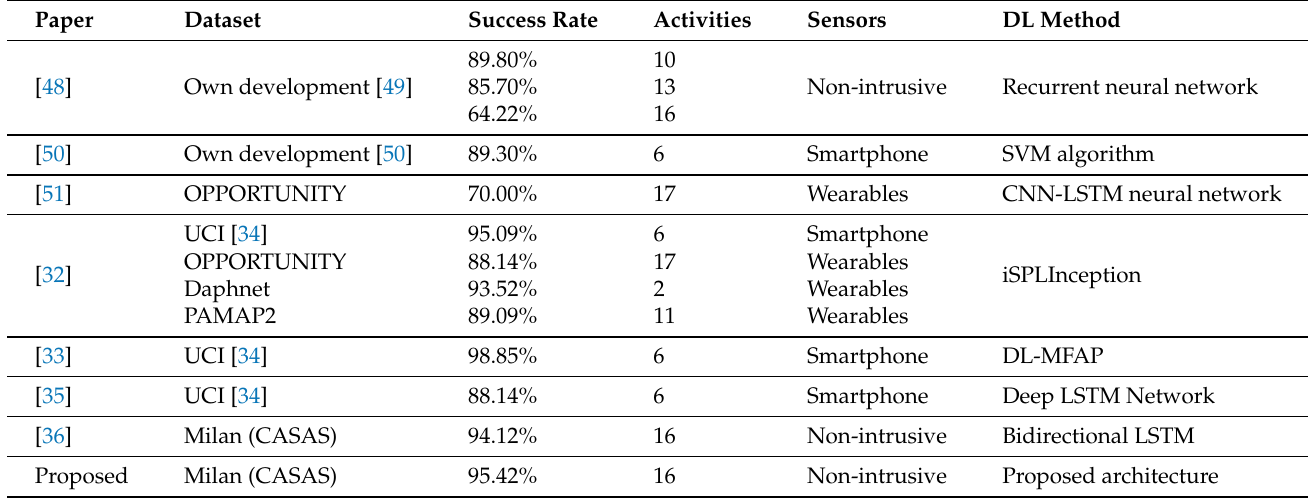
Table 5. Comparision with other similar